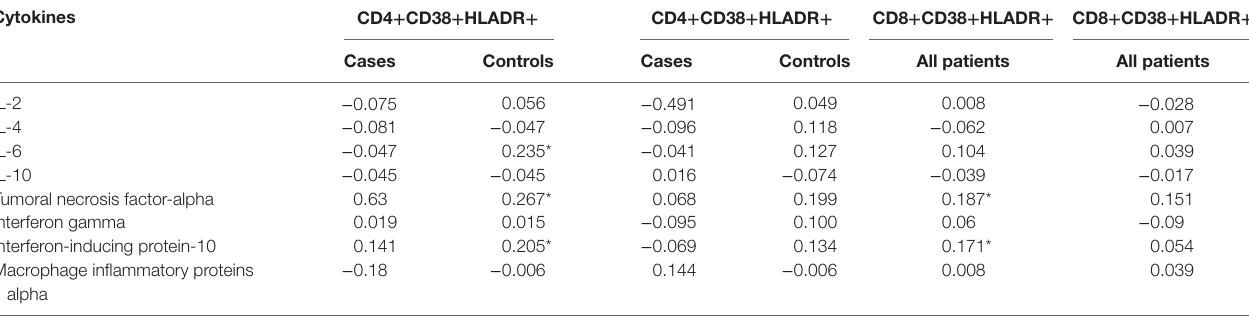
TaBle 4 | Correlations (Spearman’s rho coefficient) between frequency of CD4CD38HLADR + /CD8CD38HLADR + cells and serum levels of eight cytokines for cases and controls. cytokines